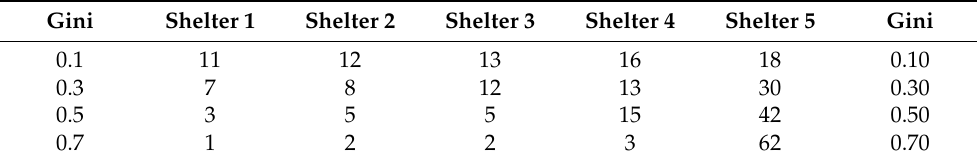
Table A5. Inputs for the simulation when the total demand is